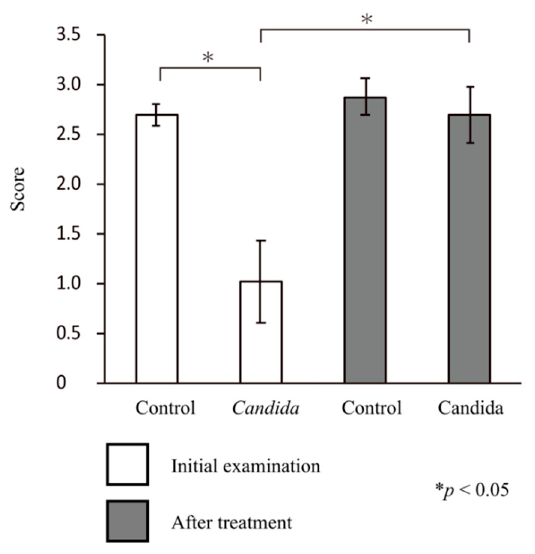
Figure 4. Bite force test. At the initial visit, bite force was significantly lower in the Candida group than in the control group ( p < 0.05). In the Candida group, bite force showed a significant improvement in pre- and post-prosthetic treatment comparisons ( p < 0.05).